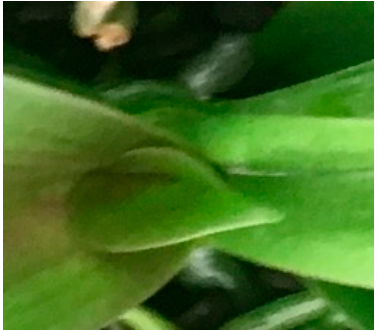
Figure 7. Direction vector of the leaf and target watering point to be modified (stem-root junction).